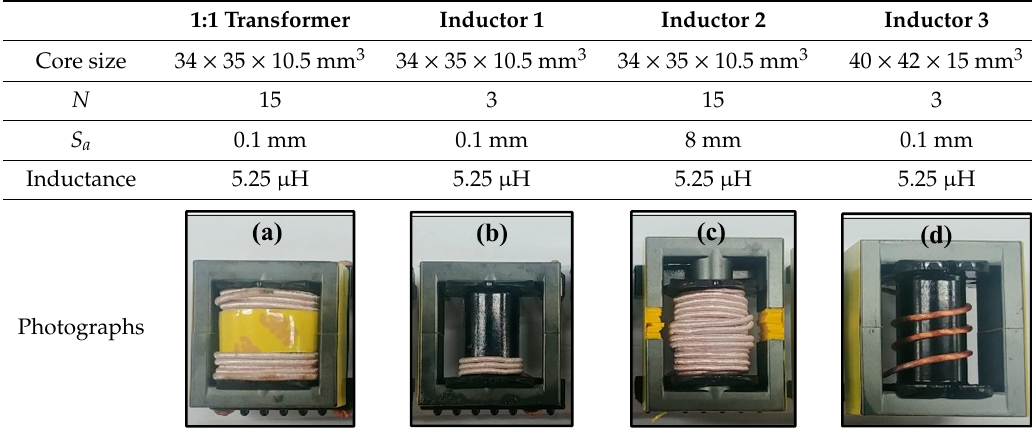
Table 4. Transformer and inductors for the experimental converters.